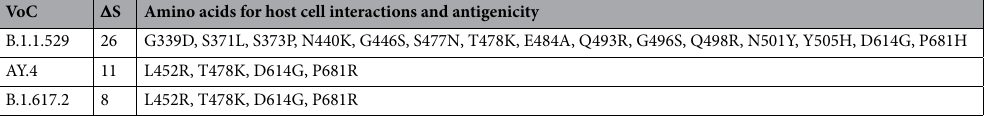
Table 2. Amino acids involved in phenotypic effects of VoCs as compared to